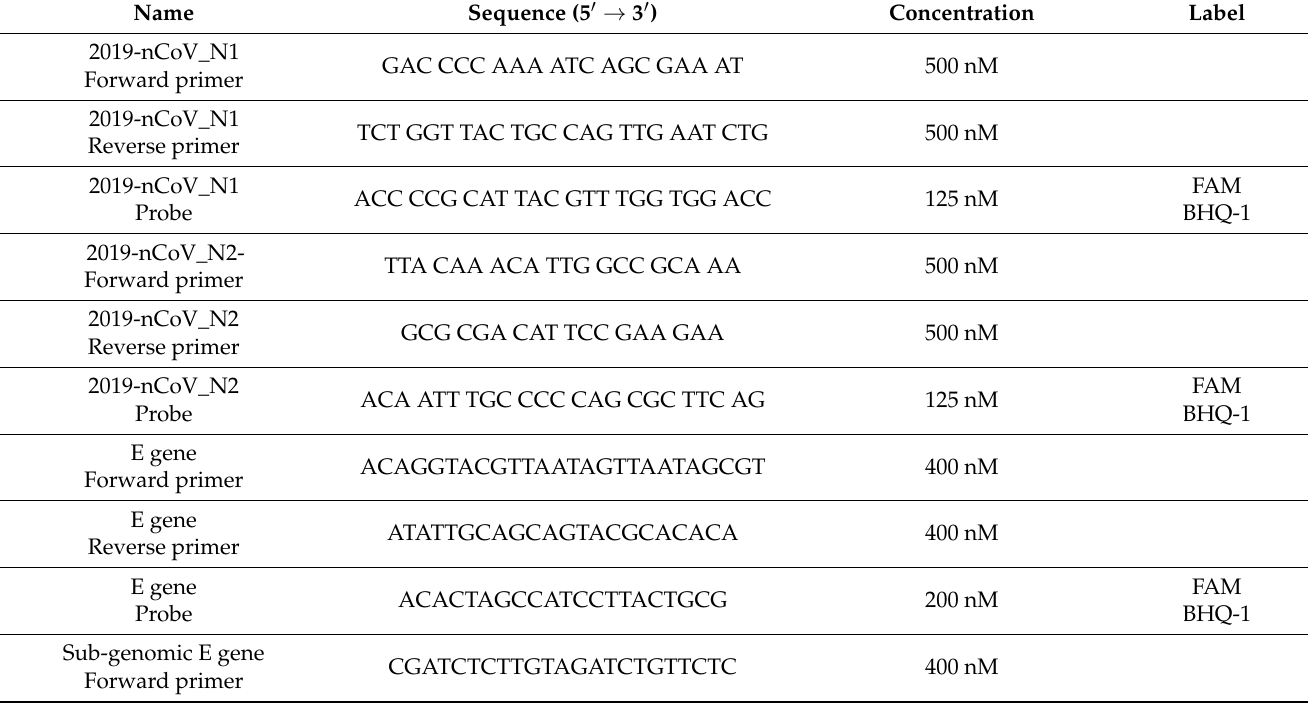
Table 1. Primers and probe for quantification of RNA viral load